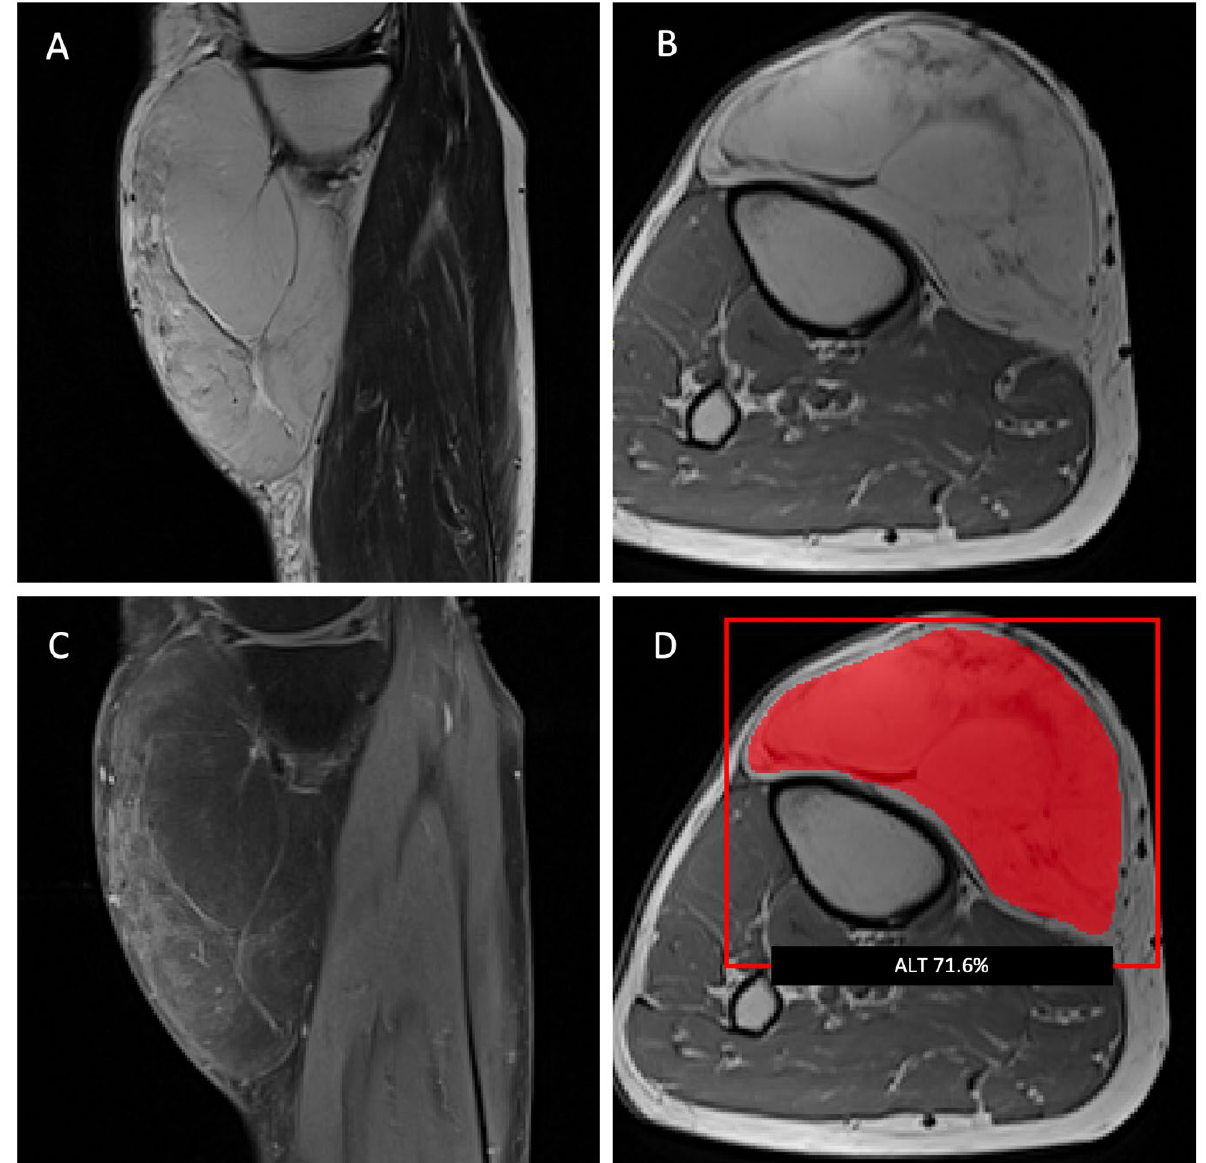
Figure 5. Sagittal T2-weighted ( A ) and axial T1-weighted ( B ) MR images of a lipomatous tumor located subcutaneously, anteromedial to the right proximal tibia. ( C ) A sagittal T1-weighted image with fat saturation shows a moderate septal contrast enhancement. All radiology residents classified this tumor as a lipoma, while the attending radiologist classified this tumor as an ALT. ( D ) The machine-learning algorithm also classified this tumor as an ALT with a probability of 71.6%. The diagnosis of an ALT was confirmed by pathology after surgical